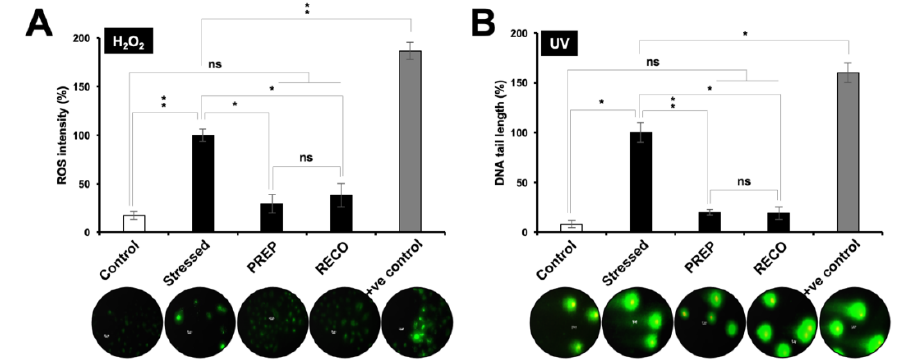
Figure 2. Anti-oxidative stress and DNA damage stress-protective potential of resveratrol. ( A ). Quantitative measure of H 2 O 2 induced reactive oxygen species (ROS) formation and its suppression in resveratrol treated cells is shown. ( B ). Quantification of UV-C radiations induced DNA strand breaks as determined by Comet assay in control and resveratrol treated cells is shown. A total of 500 µ M H 2 O 2 and 10 mJ / cm 2 UV were taken as positive controls, respectively. Resveratrol protected the cells against H 2 O 2 and UV stress both in the PREP and RECO modes of treatment.